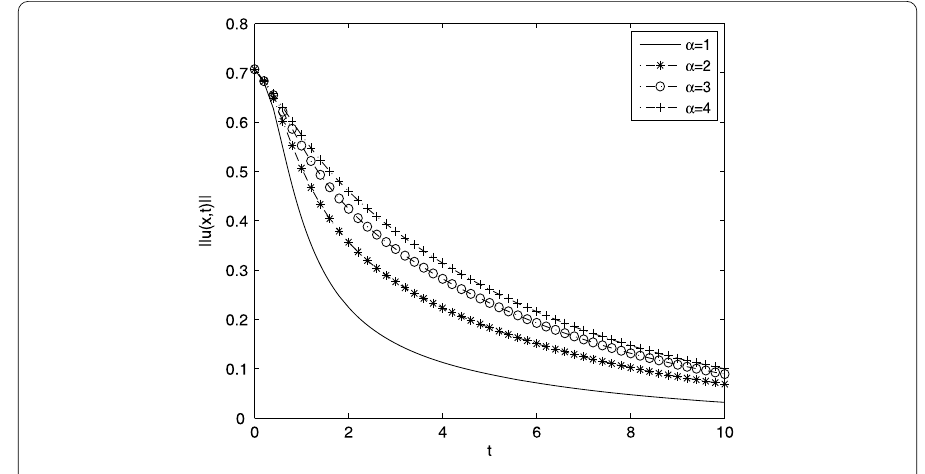
Figure 4 The L 2 -norm of u ( x , t ), (cid:5) u ( x , t ) (cid:5) versus time for different values of α when applying the linear